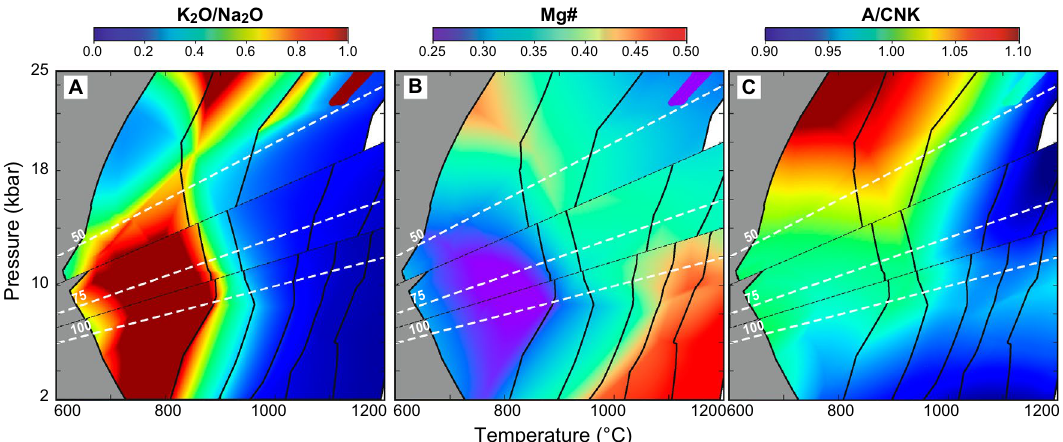
Figure 3. Color-maps showing the pressure–temperature ( P–T ) dependence on partial melt compositional characteristics. ( A ) K 2 O/Na 2 O, ( B ) Mg#: (Mg/Fe + Mg), and C: A/CNK: (Al/Ca + Na + K; ASI). Phase equilibria and MLE are the same as those shown in Fig. 1. Calculations were performed using Theriak-Domino software 24 (Version